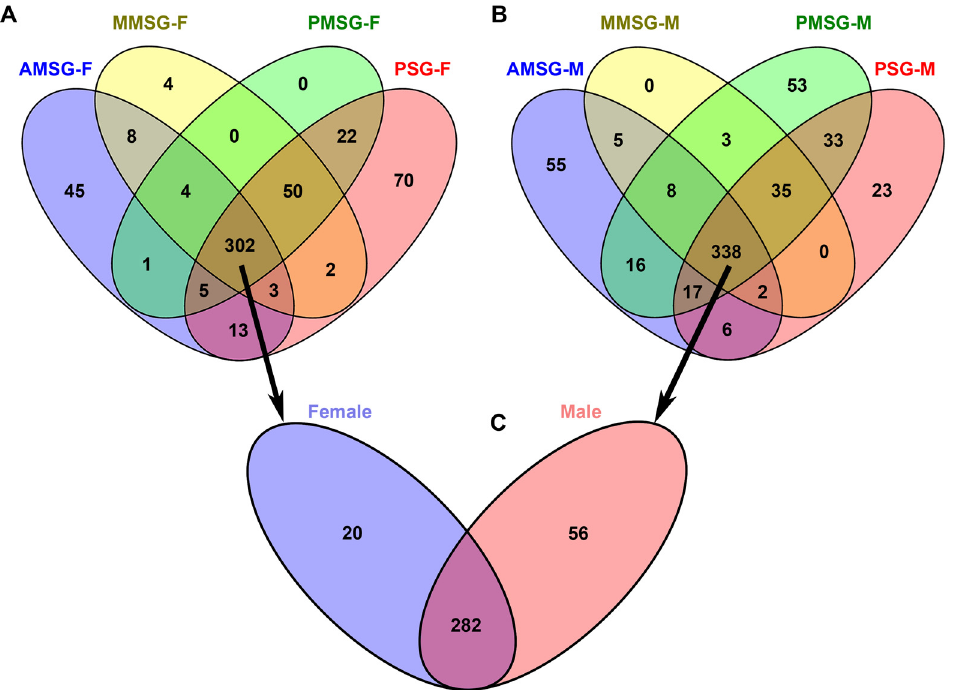
Fig 3. Venn diagram of the up-regulated genes between ASG and other parts of the silk gland. (A) Respective overlaps of up-regulated genes in the ASG vs other parts of the silk glands from female silkworms. (B) Respective overlaps of up-regulated genes in the ASG vs other parts of the silk glands from male silkworms. (C) Up-regulated genes in the ASG and other parts of silk glands from females and males.